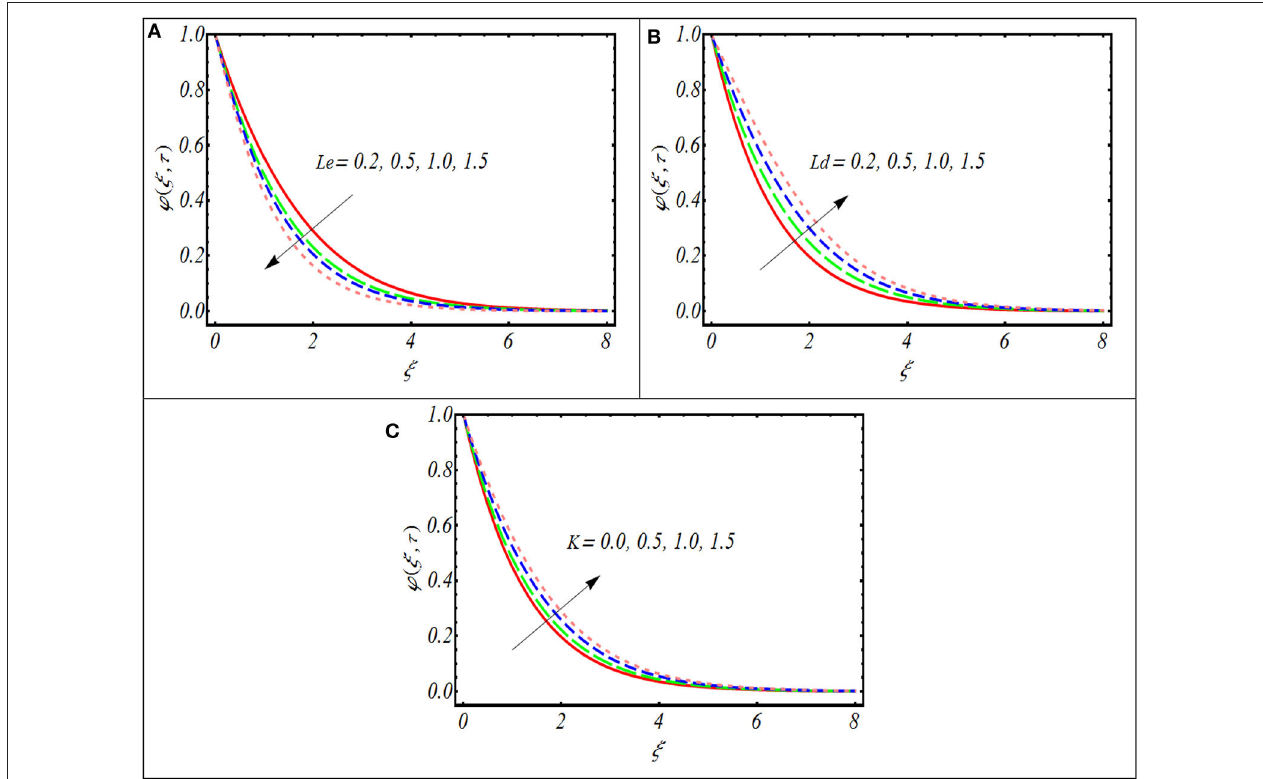
FIGURE 5 | Impact of (A) Le , (B) Ld , and (C) K on solutal concentration.